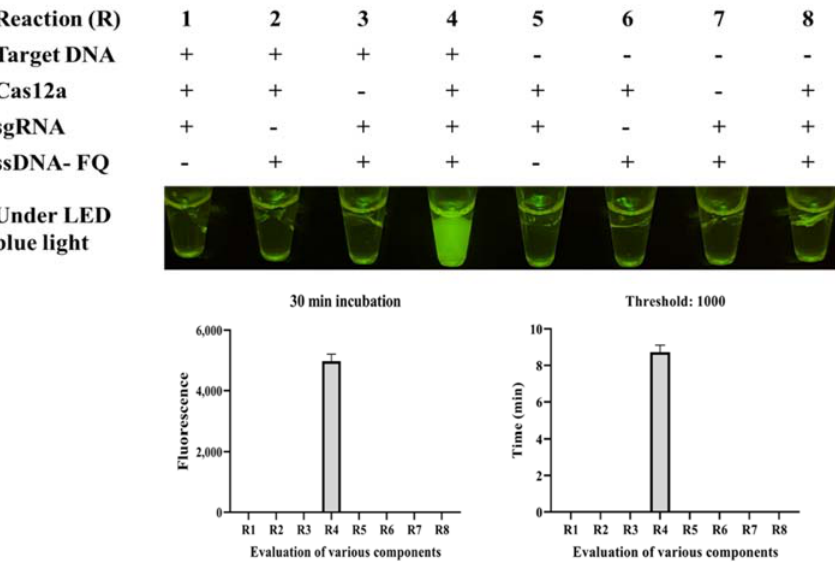
Figure 4. Evaluation of eight CRISPR/Cas12a reactions (R) with various components through endpoint imaging after 30 min of incubation and real-time fluorescence detection. The LAMP products, Cas12a, sgRNA, and the ssDNA-FQ reporter were tested. After incubation at 37 °C for 30 min, only reaction 4, containing the target nucleic acid sequence, sgRNA, Cas12a, and the ssDNA-FQ reporter, produced a superbright fluorescence signal under LED blue light. The real-time monitoring was conducted in a CFX96 Touch Real-Time PCR Detection System for 30 min, and the endpoint fluorescence intensity and time with a fluorescence threshold of 1000 were monitored.